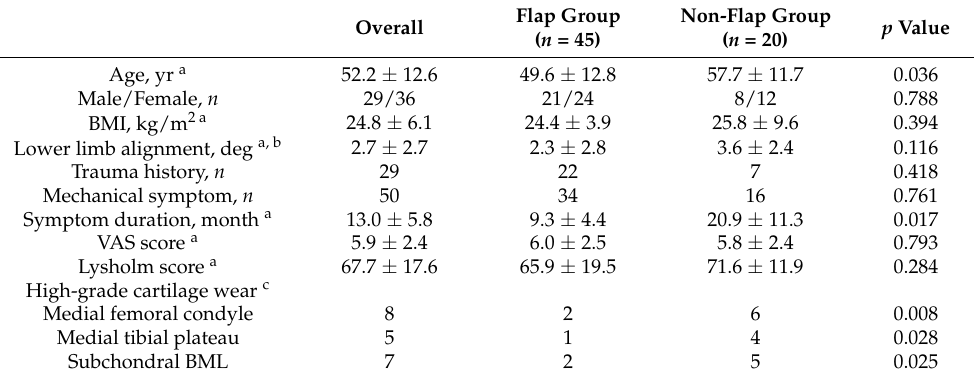
Table 1. Patient characteristics according to unstable flaps.